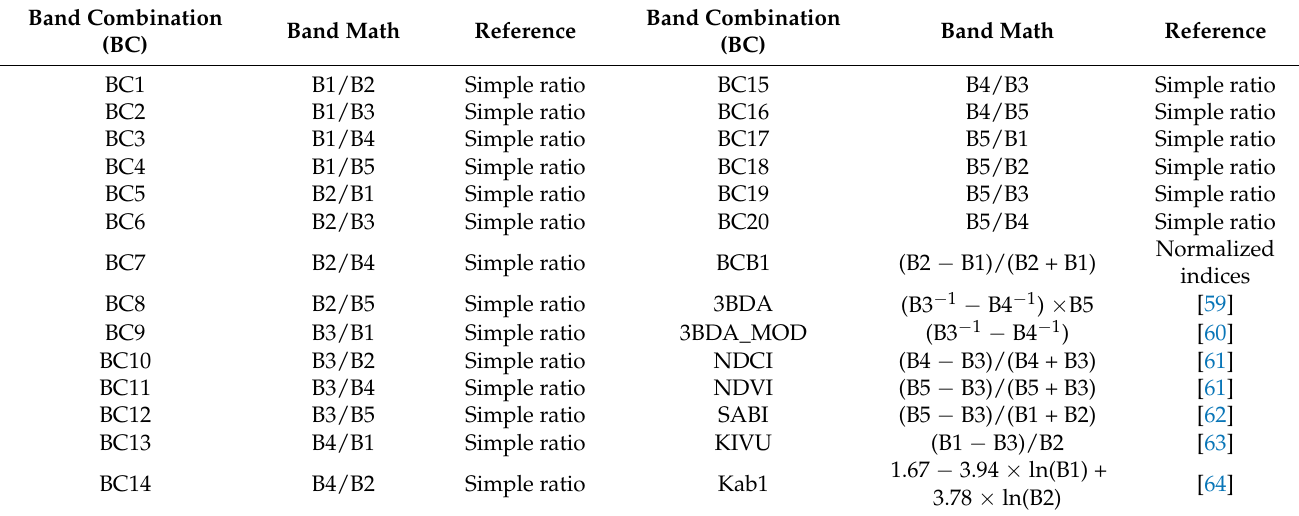
Table 1. Band combinations used for establishing inversion models.